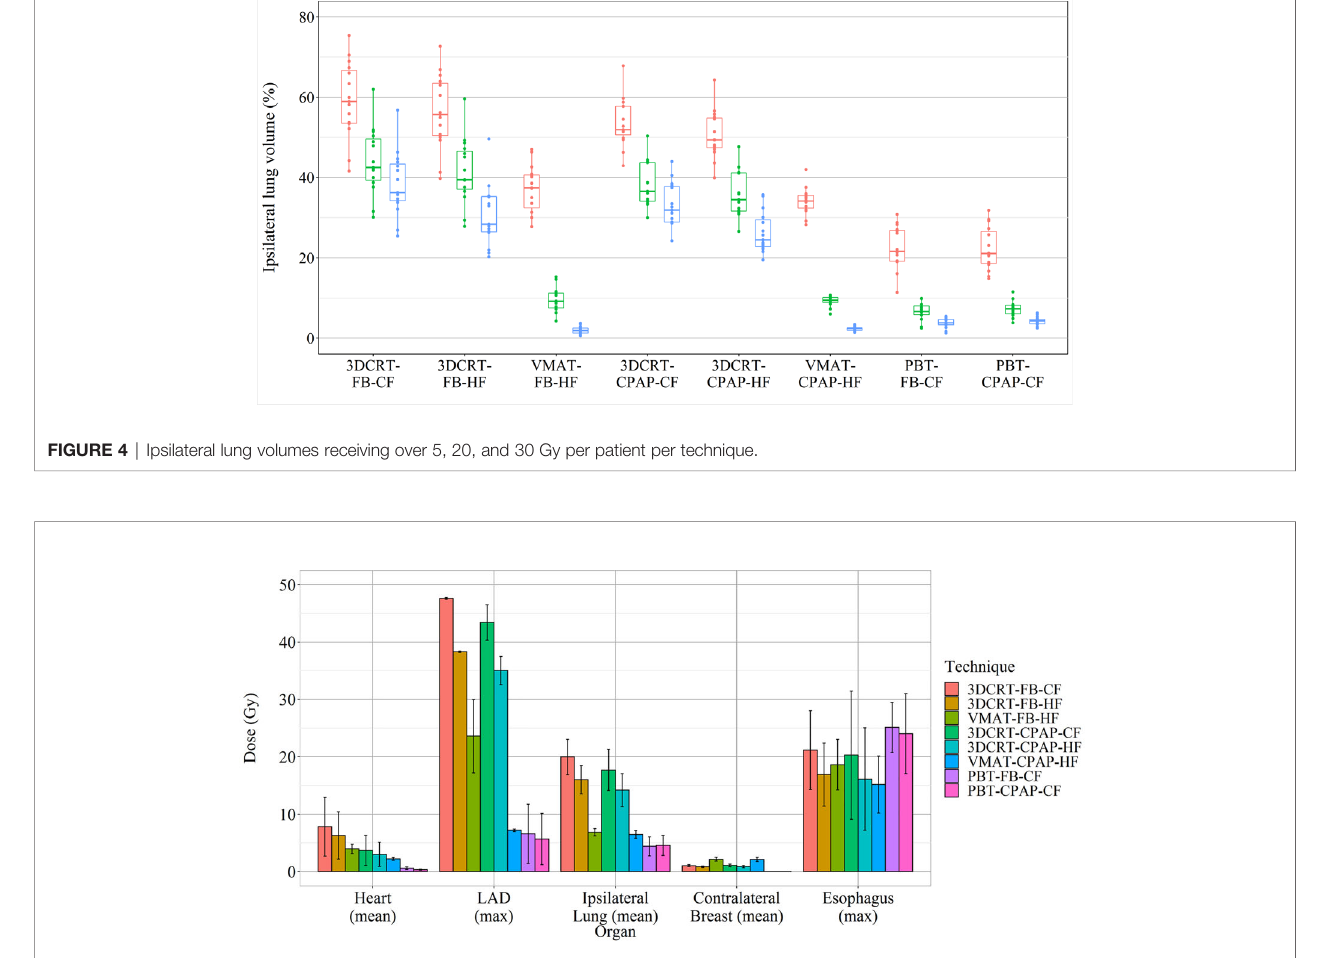
FIGURE 5 | Doses to organs-at-risk per technique, aimed at decreasing the mean heart